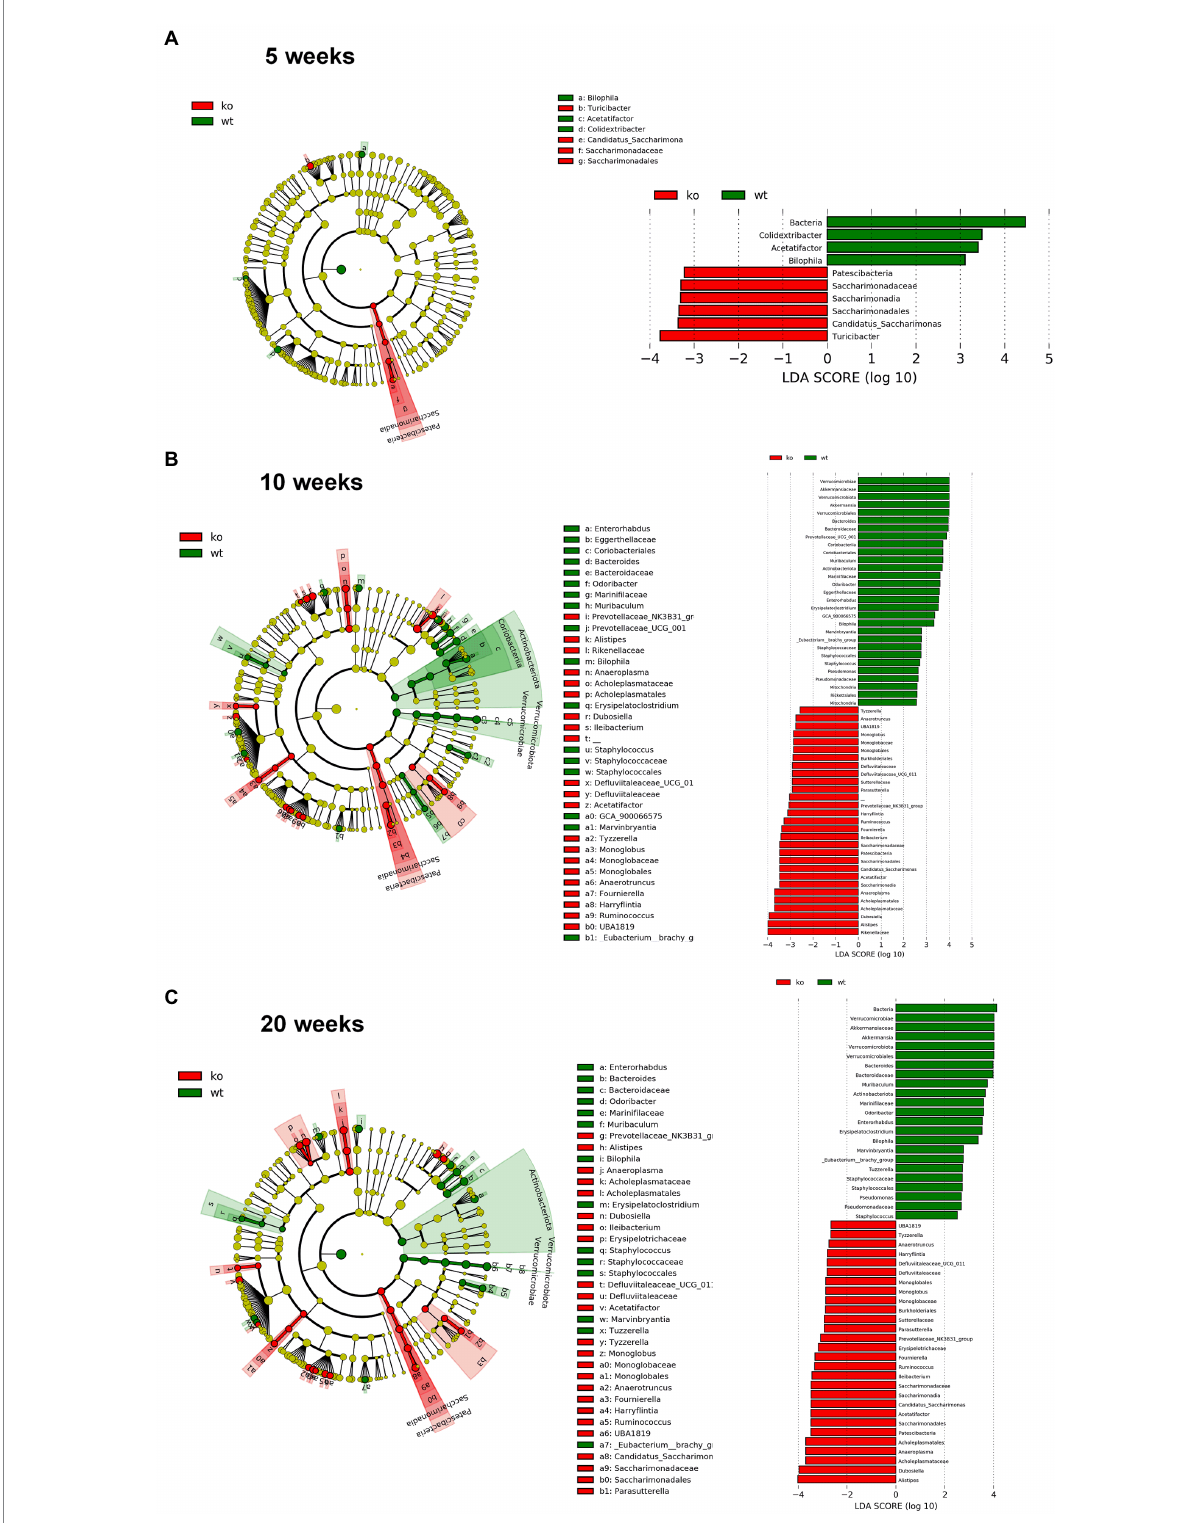
FIGURE 6 Comparison of the differences in the composition of the microbiota of C57Bl/6 wild type (WT) and IL-10 deficient mice (IL-10 −/− ) IL-10 −/− from colonic mucosa samples with linear discriminant analysis effect size (LEfSe) at ages 5 (A) , 10 (B) and 20 weeks (C) . Significant differences are considered from 2.0 on the logarithmic scale, both positive and negative. The cladogram indicates the importance of the changes in the bacterial composition for the rest of the populations of the